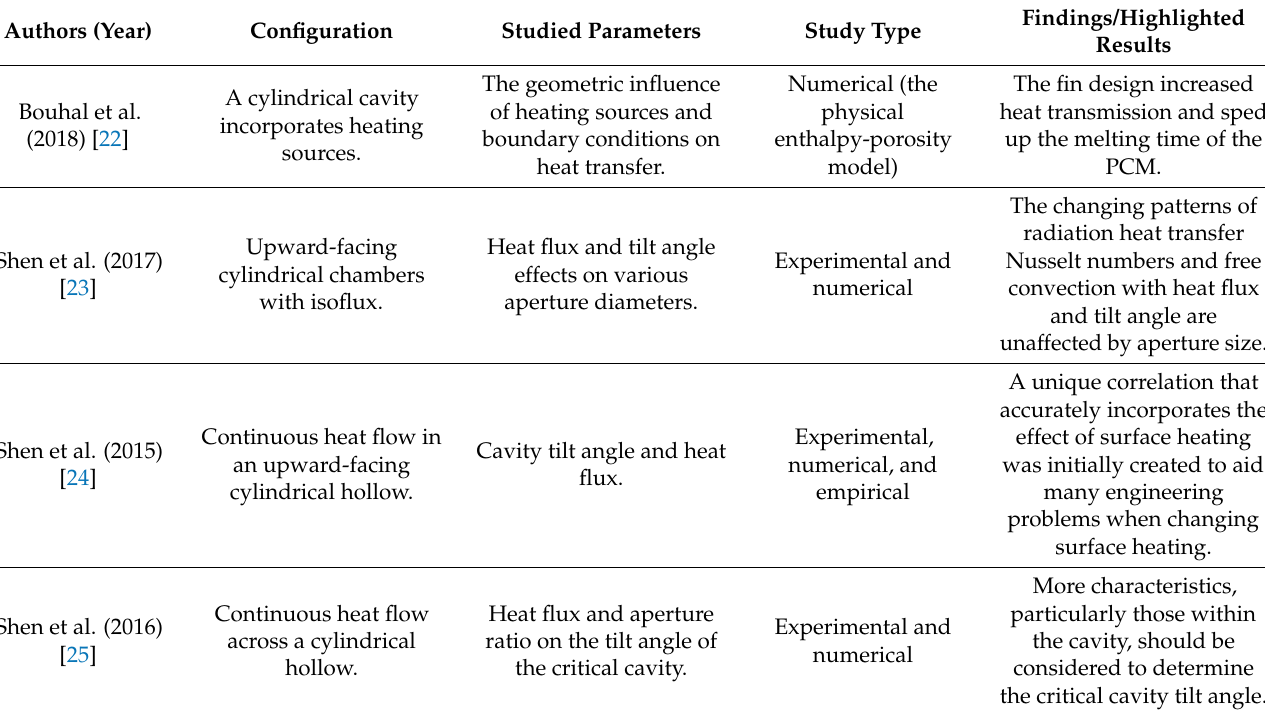
Table 2 provides a summary of review on cylindrical cavities. Table 2. Summary of review on cylindrical